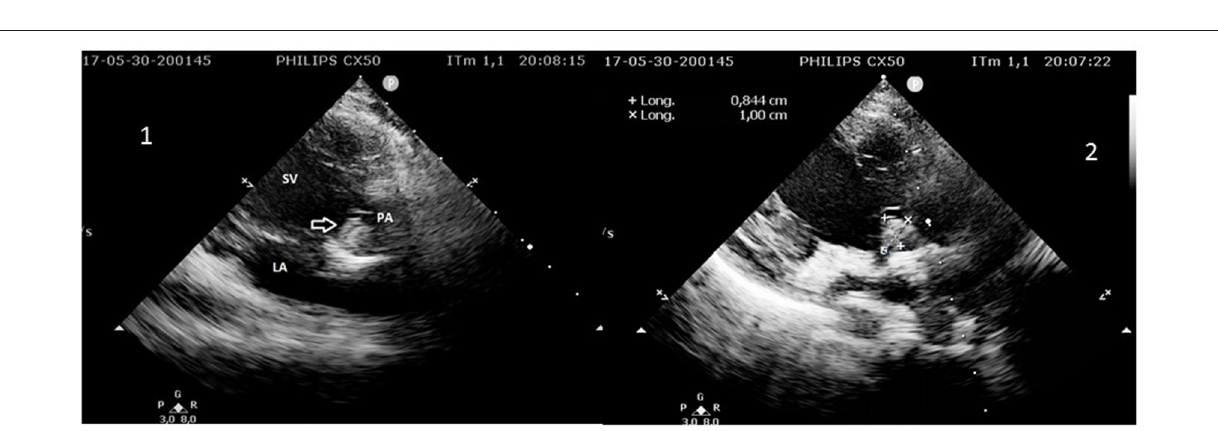
and is waiting for a third surgery planned to be a total cavopulmonary anastomosis which will be performed during the elementary